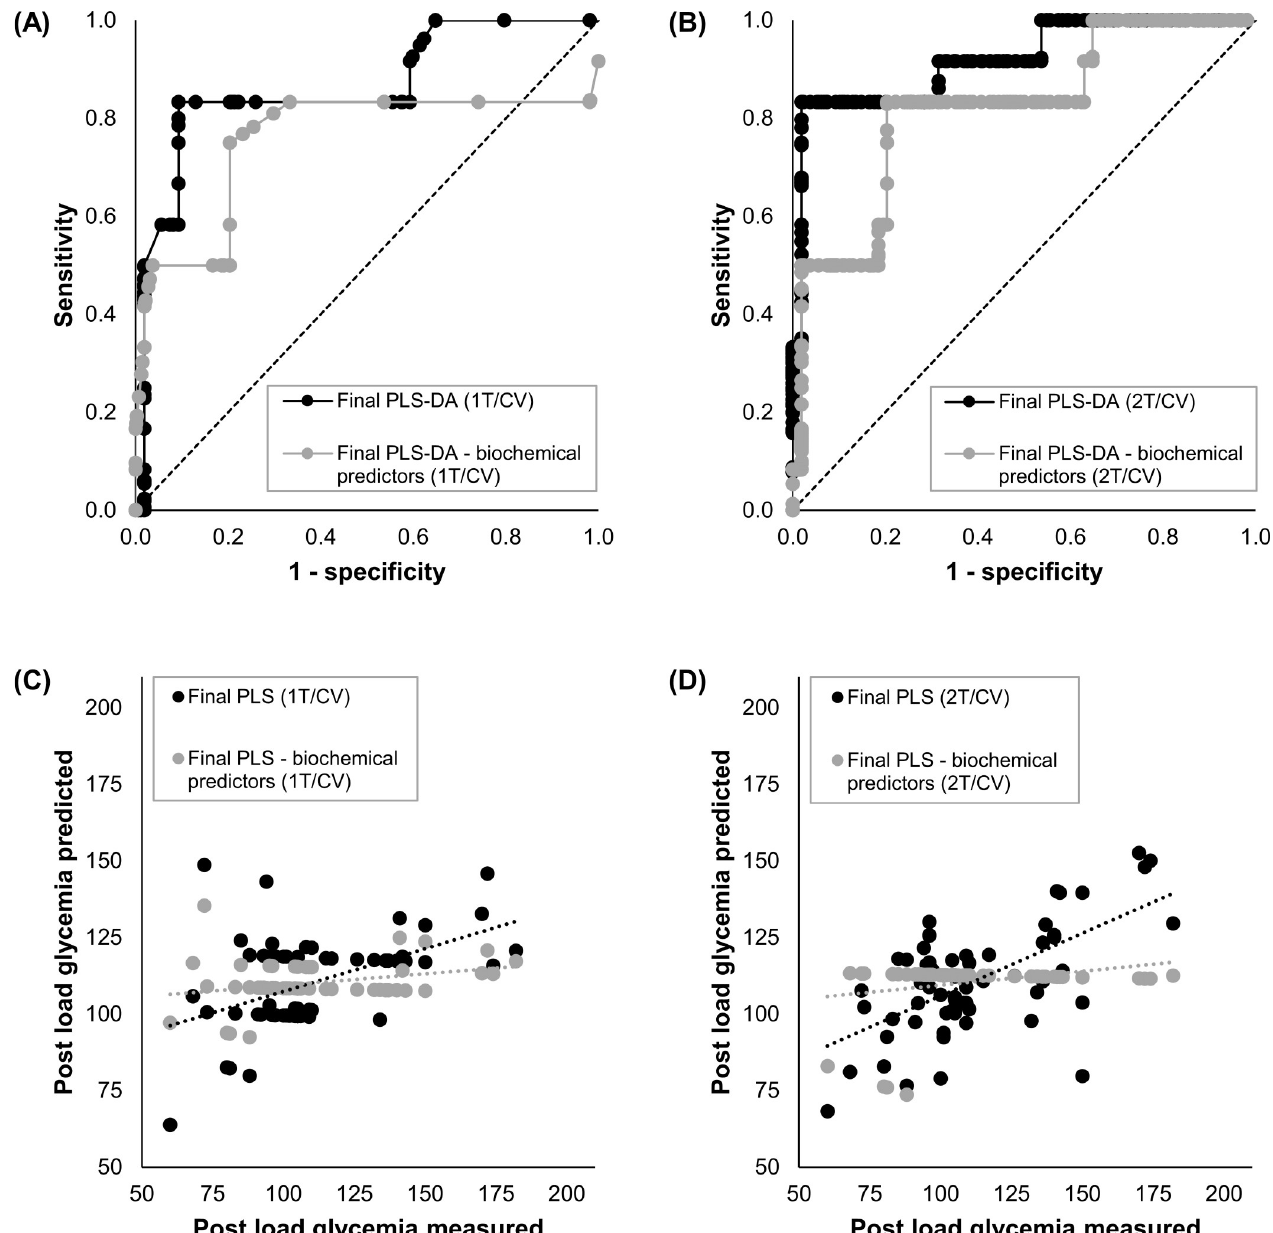
Fig 4. Cross-validation performance of the final machine learning models that predict gestational diabetes mellitus and post load glycemia. A-B) For the prediction of GDM in the first (A) or second (B) trimester of pregnancy by PLS-DA. C-D) For the prediction of post load glycemia in the first (C) or second (D) trimester of pregnancy by PLS. The four plots show the cross-validation performance of the final models with their full set of predictors (black) and after the remotion of biochemical markers (grey). 1T : First trimester . 2T : Second trimester . PLS-DA : Partial least squares discriminant analysis . PLS : Partial least squares . CV : Cross-validation